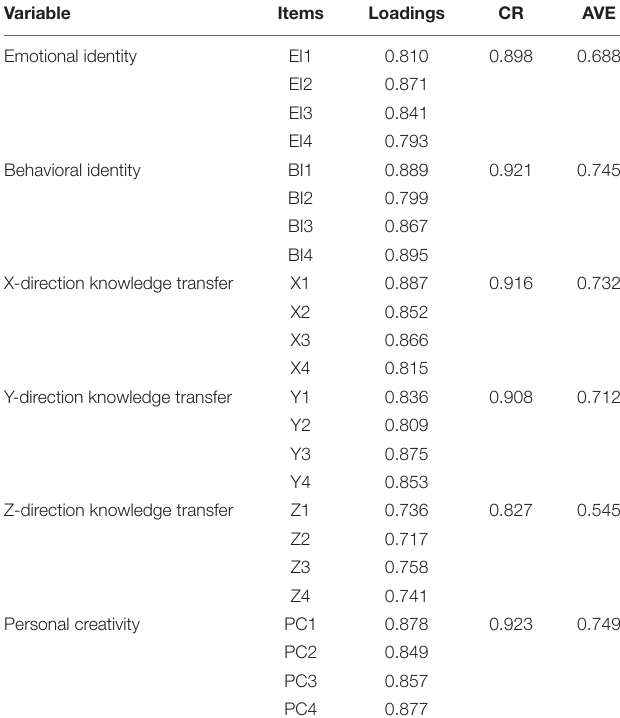
TABLE 4 | Results of factor loadings, composite reliability (CR), and